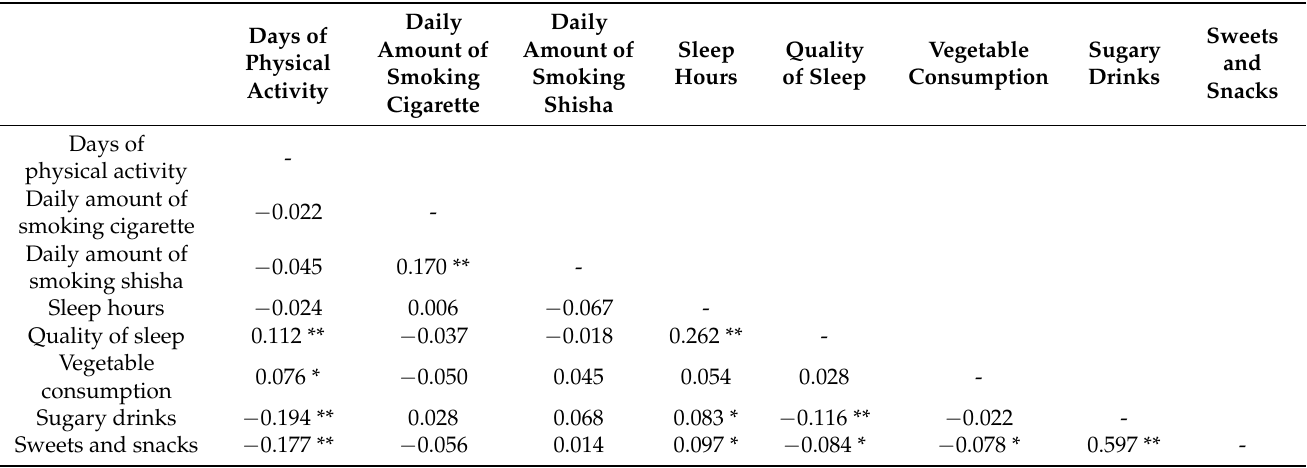
Table 3. Correlations between health behaviors.